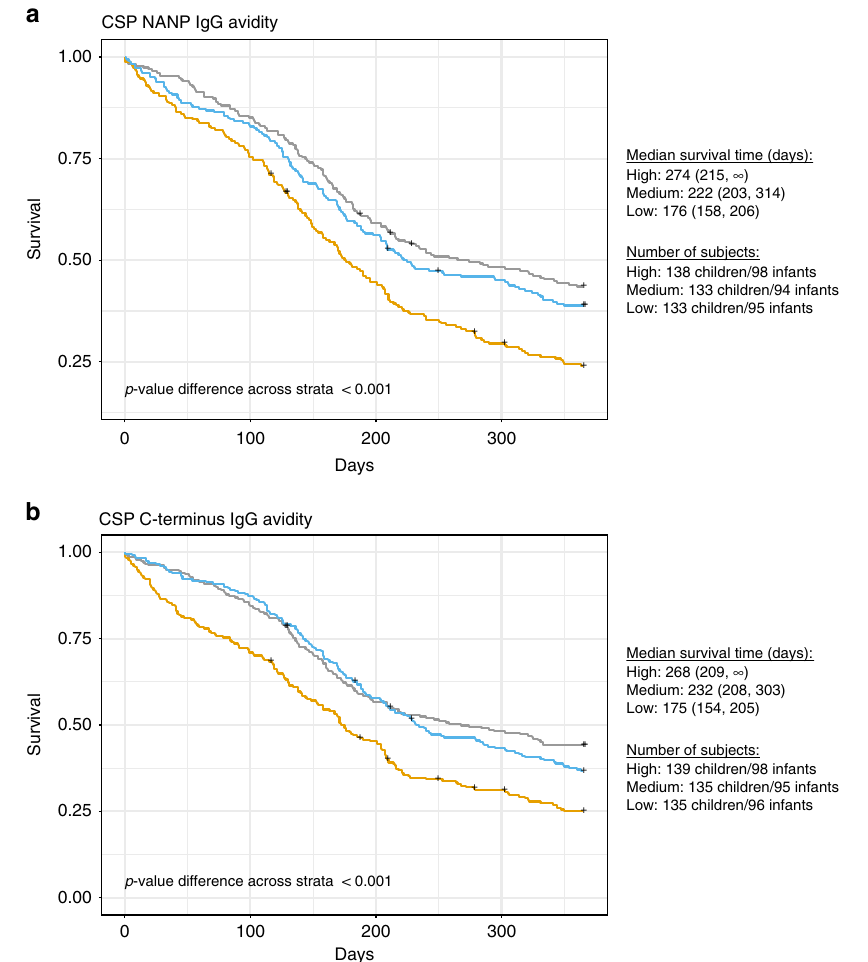
Fig. 4 Effect of CSP antibody avidity on protection against the fi rst malaria episode. Kaplan – Meier estimates of time to the fi rst clinical malaria episode during the 12-month follow-up period after the third vaccine dose by the three tertiles (high in grey; medium in blue; low in yellow) of avidity index values at month 3 in RTS,S/AS01E vaccinees. Only plasma/serum samples which IgG concentrations were above the lower limit of quanti fi cation (LLOQ) (1.43 EU mL − 1 and 2.79 EU mL − 1 in NANP ( a ) and C-terminus [C-term] ( b ), respectively) were included. The median value for NANP was 0.43 and for C-term 0.11 and the number of subjects included was n = 691 for NANP and n = 698 for C-term. The median survival time (days), i.e., time at which the survivorship function equals 0.5, are shown next to the plots for each strata with the corresponding 95% con fi dence intervals. p -values assessing differences in the distribution of survival time between the two strata were signi fi cant and have been estimated through the Log-rank test. The number of subjects in each tertile are also indicated next to the plots, strati fi ed by age